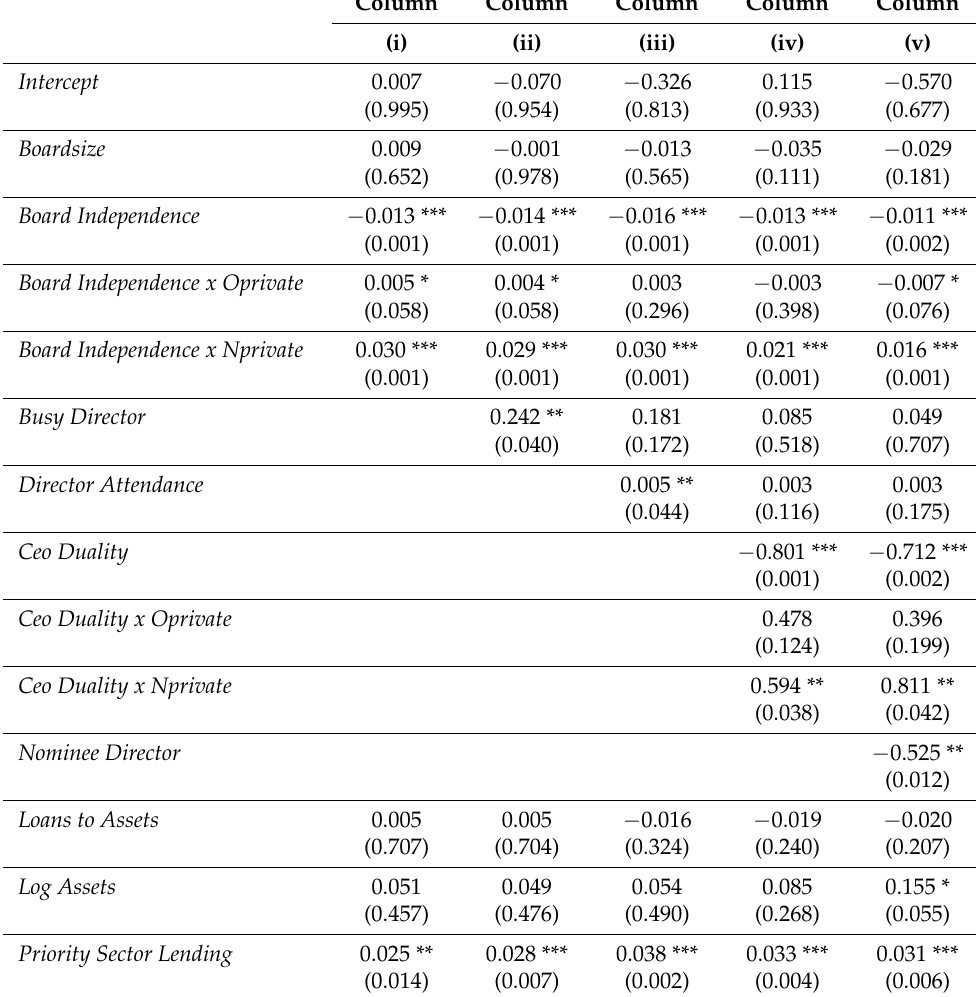
Table 5. Board Characteristics and Bank Value: Dependent Variable—Market to Book Value Ratio. Column Column Column